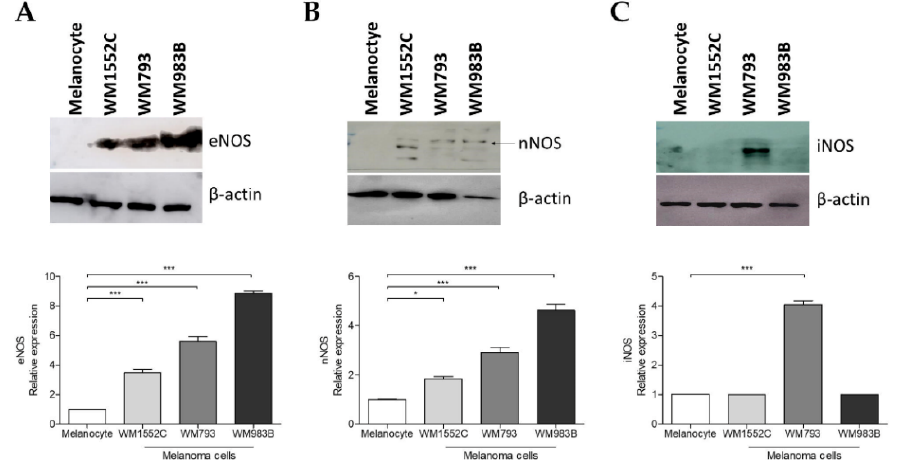
Figure 4. Melanoma cells exhibit increased protein expression of nitric oxide synthases. Expressions of eNOS ( A ), nNOS ( B ), and iNOS ( C ) in melanocytes and in WM1152C, WM793, and WM983B melanoma cells were determined by Western blot using specific antibodies. The Western blot images show representative results of three independent experiments. Values are reported in the bar graphs and expressed as the means ± S.D. The experiments were performed in quintuplicate, and p -values were based on the one-way ANOVA test, followed by Bonferroni’s post-test; *, p < 0.05 and ***, p <